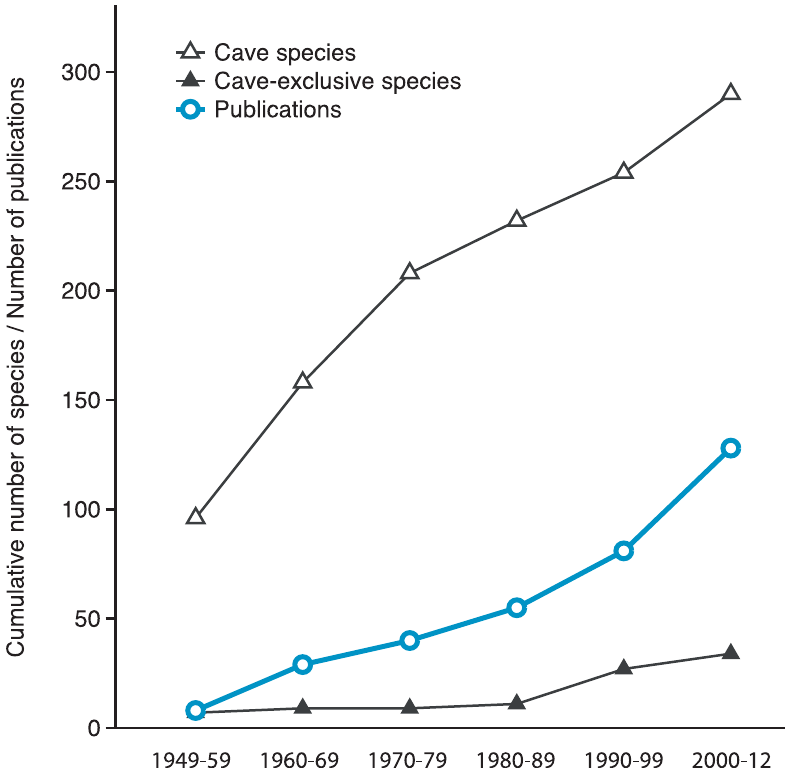
Figure 1. Sponge species recorded from Mediterranean marine caves through time, alongside with research effort.